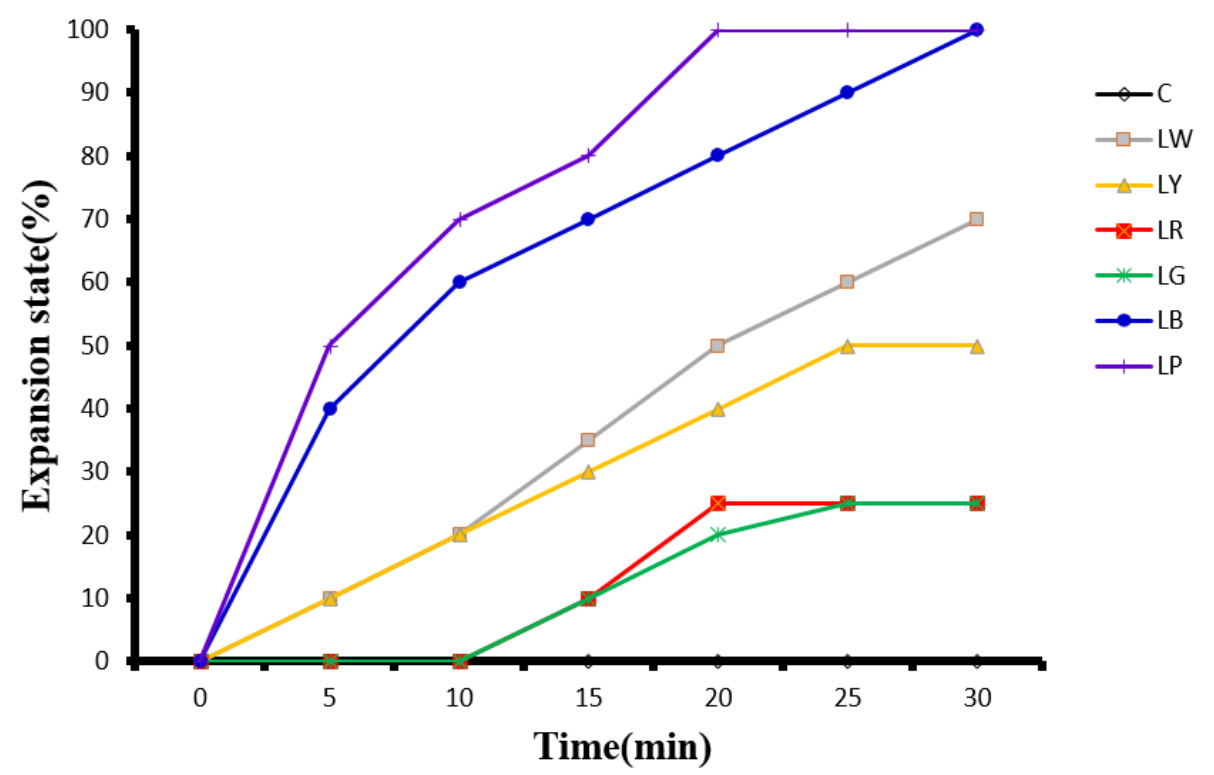
Figure 5. Extension state of Goniopora columna polyps after illumination under different light sources. After 2 h of acclimatization to darkness, the specimens were either left in darkness or illuminated with LW, LY, LR, LG, LB, or LP light for 30 min. The stretching and contractile behaviors of the polyps were captured using a Canon EOS 750D camera.